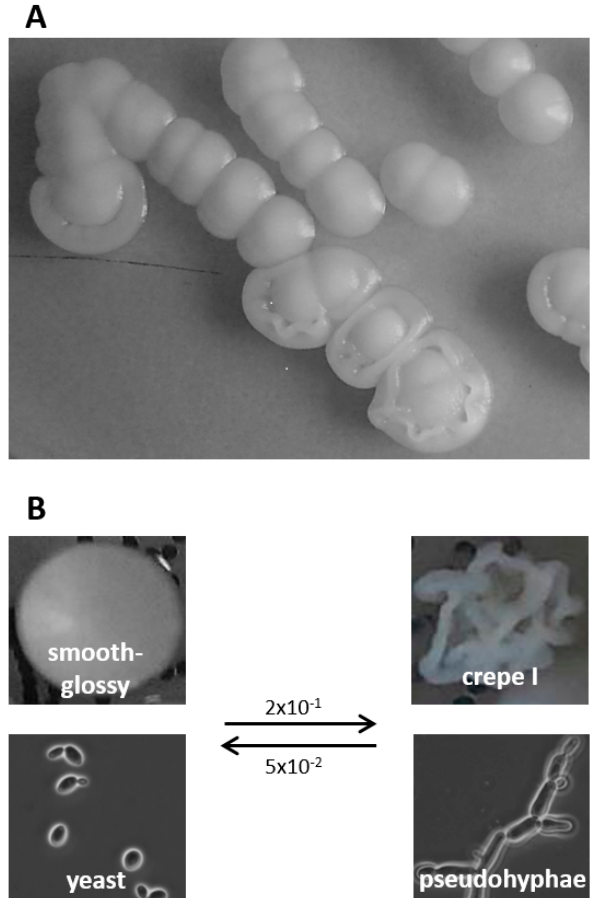
Figure 1. Colony morphotypes formed by C. parapsilosis . ( A ) Mixed morphotypes observed on a routine diagnostic plate. ( B ) Cells with distinct morphological colony phenotypes can be sub-cultured, but some strains (here strain PEU582: smooth-glossy vs. crepe, see below) sometimes undergo switching with strain-dependent frequencies. Smooth colonies are composed mainly of yeast-form cells, whereas non-smooth colonies are composed of pseudohyphal cells or mixtures of both morphologies.